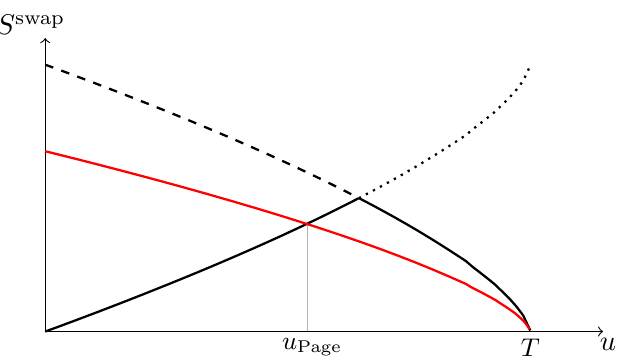
Figure 14. The u -dependent swap entropy computed from PS saddles (solid black curve) rapidly transitions from agreement at small u with S Hawking ( u ) (increasing black curve) to agreement at large u with ¯ S Hawking ( u ) (decreasing black curve). The transition occurs at the u 0 for which S Hawking ( u 0 ) = ¯ S Hawking ( u 0 ) . However, because S Hawking ( ∞ ) > S BH (0) , we have S Hawking (0) > S BH (0) and in fact also at all u . In particular, S Hawking ( u 0 ) = ¯ S Hawking ( u 0 ) exceeds S BH ( u 0 ) , violating BH